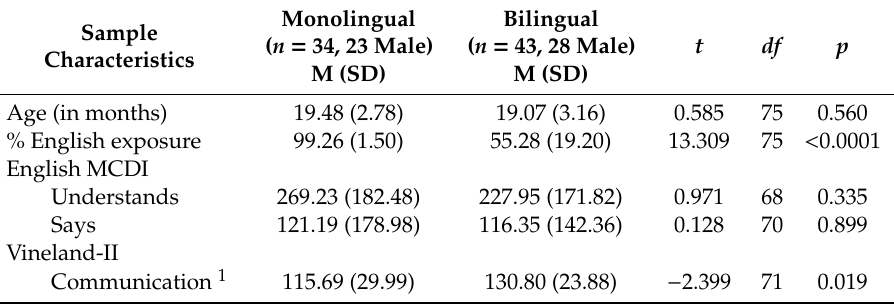
Table 2. Sample characteristics by language